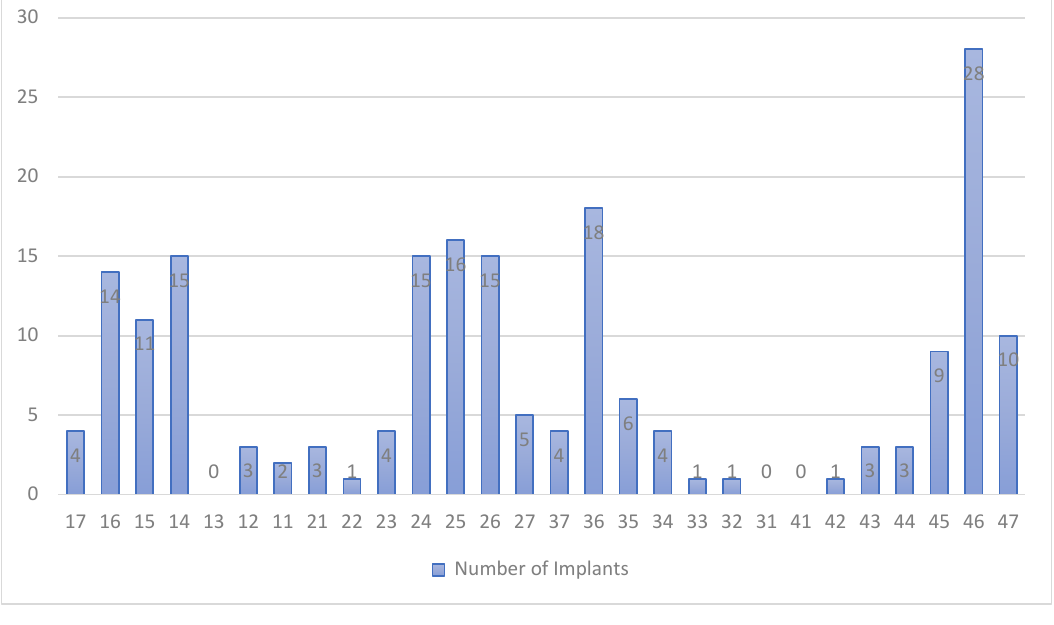
Figure 1. Location of implants.